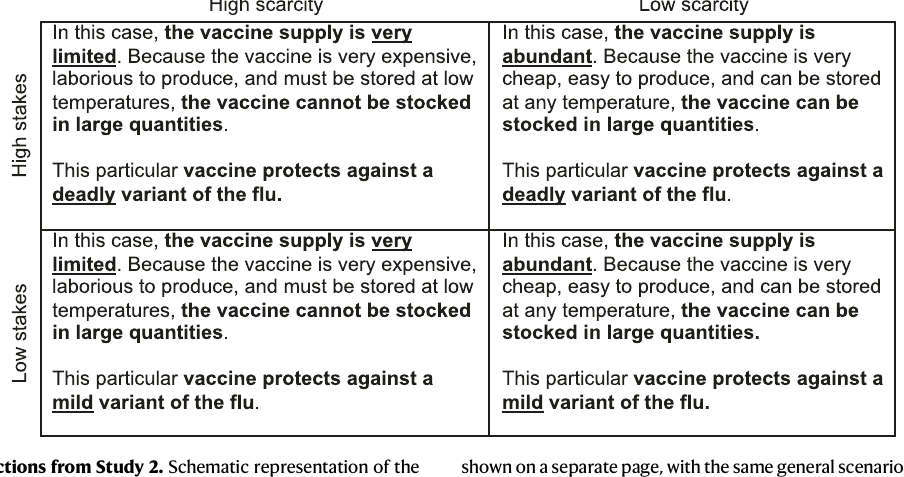
shownonaseparatepage,withthesamegeneralscenariodescribedatthetop.The